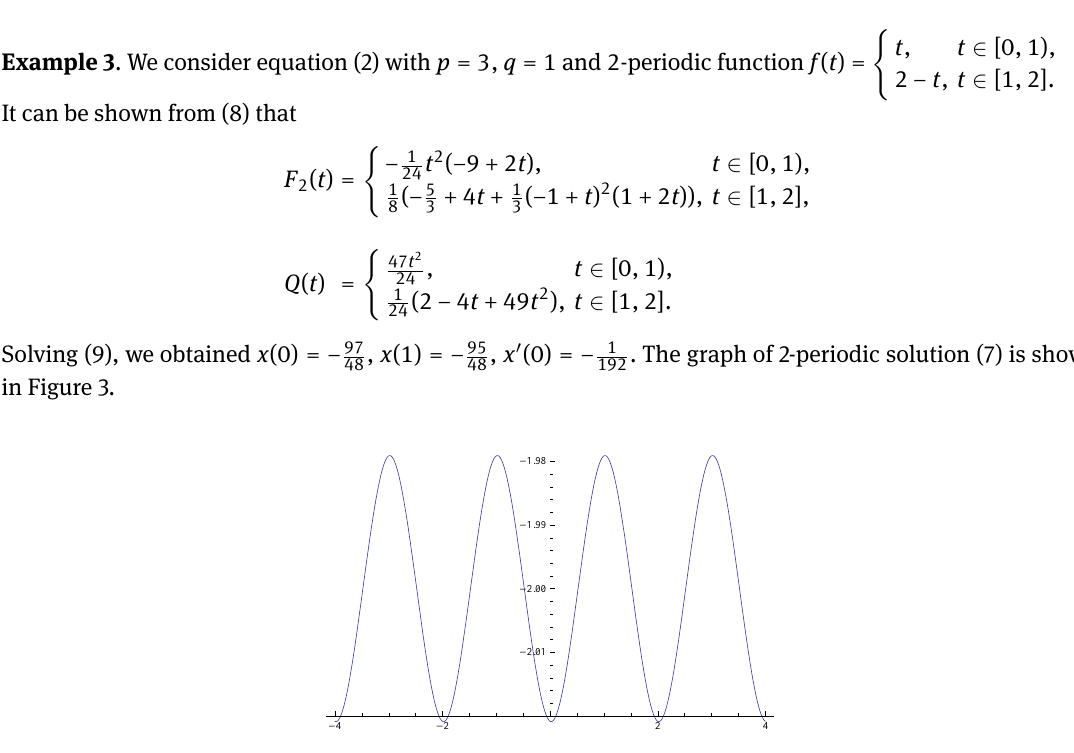
Figure 3: The graph of 2-periodic solution x ( t ) of equation (2) for Example